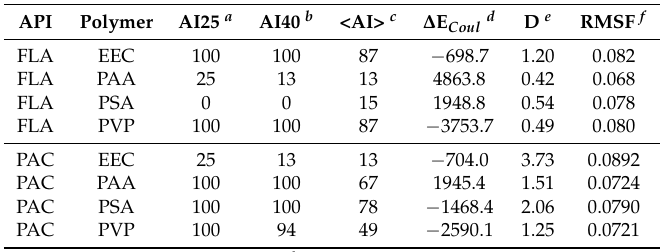
Table 2. Thermodynamic and kinetic descriptors from MD simulations of eight API–polymer blends compared to experimental literature